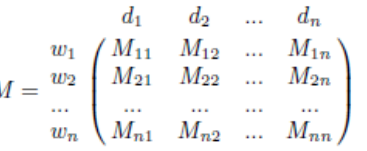
Fig. 2: Representation of a co-occurrence matrix M, each column represents a vector of a particular sample and each row represents a vector of a particular token.